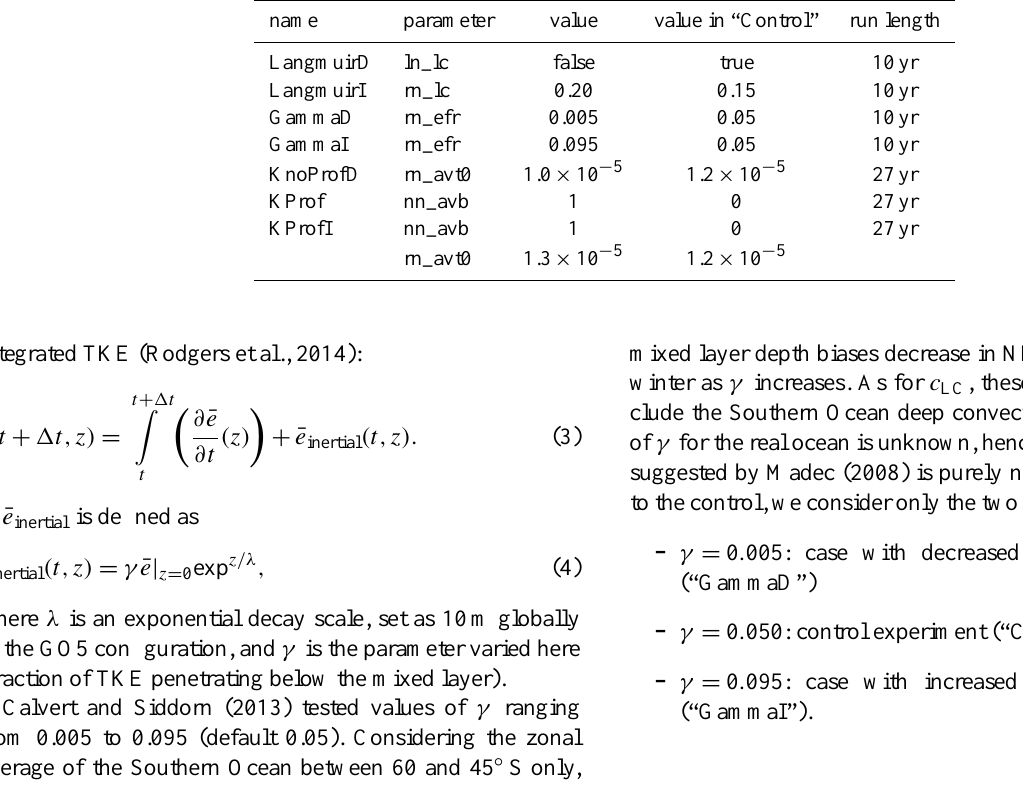
Figure 1. NEMO3.4, control run, for each grid point, maximum monthly mixed layer depth between January 1980 and December 1989. The blue box indicates the Riiser-Larsen Sea region, which is overlaid by the magenta box that indicates the Weddell Sea region studied in Sect. 3.2. Table 1. Sensitivity experiments performed on NEMO3.4, detailed in Sect. 2: “Langmuir” experiments look at Langmuir turbulence velocity scale, “Gamma” at the penetration of an additional turbulent kinetic energy term below the mixed layer, “Knoprof” and “KProf” at back- ground diffusivity. “I” indicates that the parameter was increased compared to the reference value, “D” that it was decreased. The parameters column identifies the shorthand name used in the NEMO simulation name list. Note that the “Control” run is 10 years